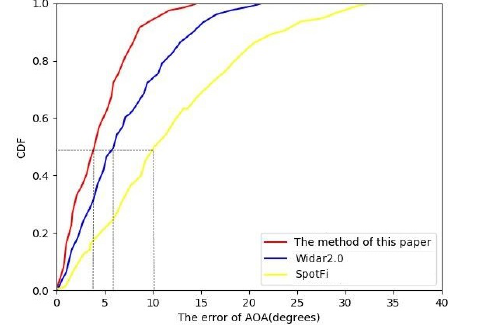
Figure 8. AOA cumulative error of different